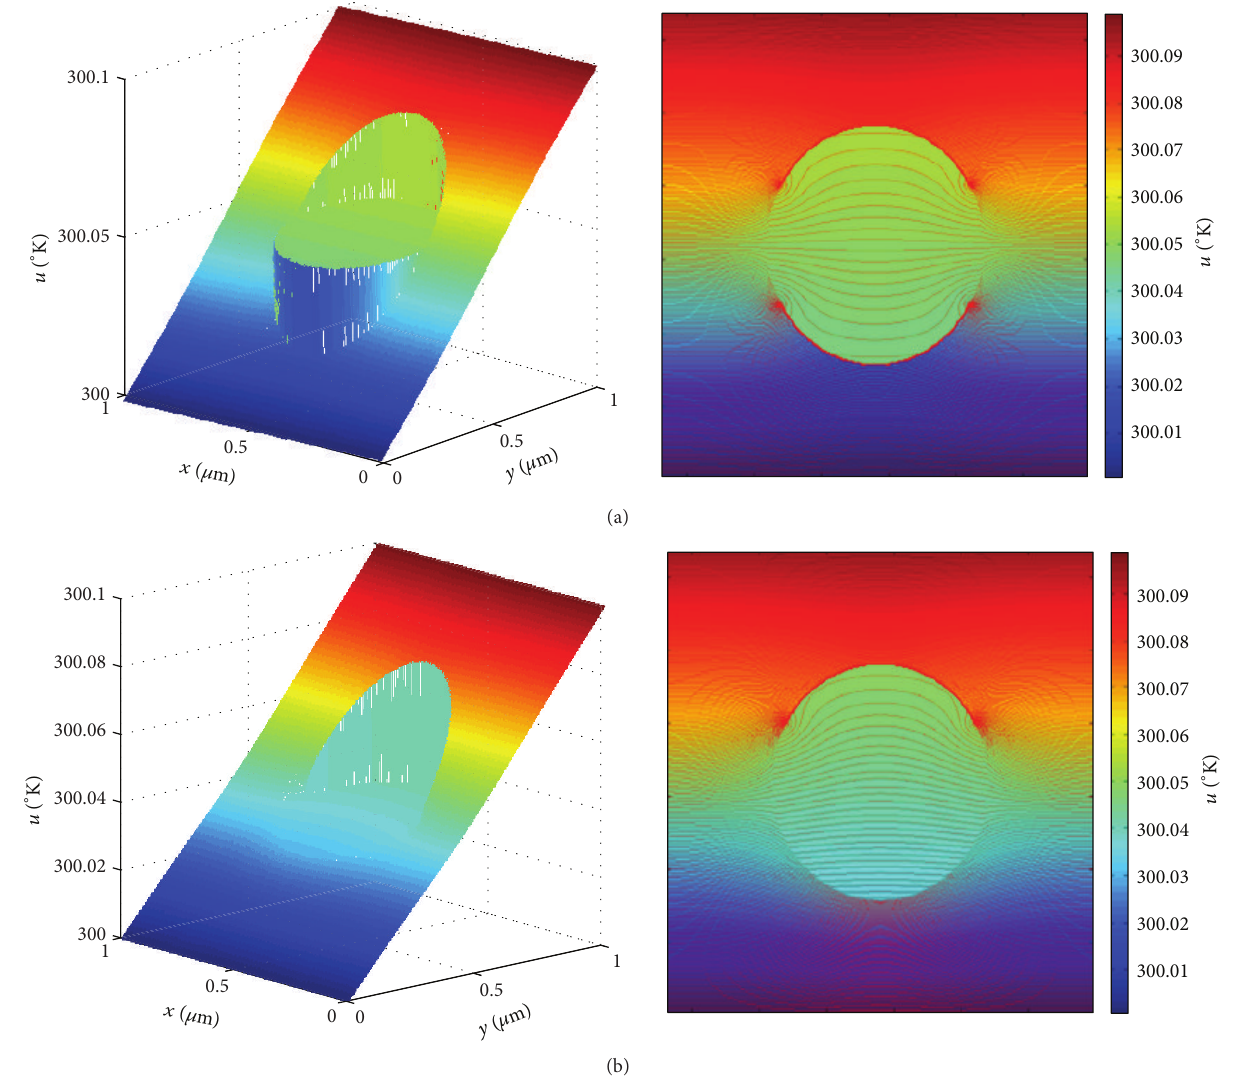
Figure 3: Temperature field in the heterogeneous media with. (a) Double partial debonding of circular inclusion; (b) single partial debonding of circular